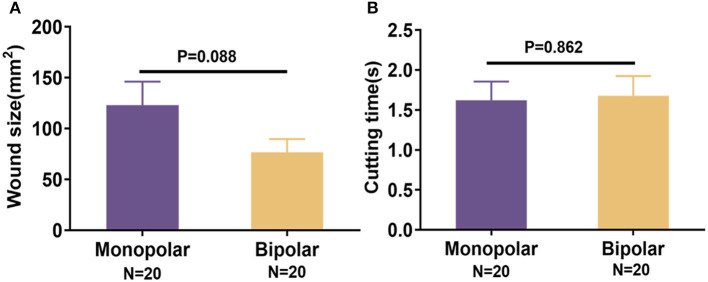
Comparison of wound size (A) and cutting time (B) in porcine experiments between monopolar group and bipolar group. Data were presented as means ± SD (N = total quantity of resection). P-values were calculated using the Student t test.